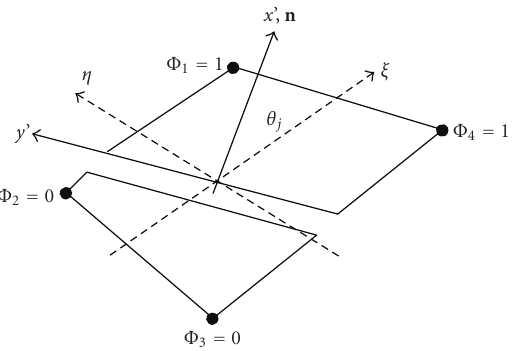
Figure 4: Computation of φ values at the virtual midplane of the